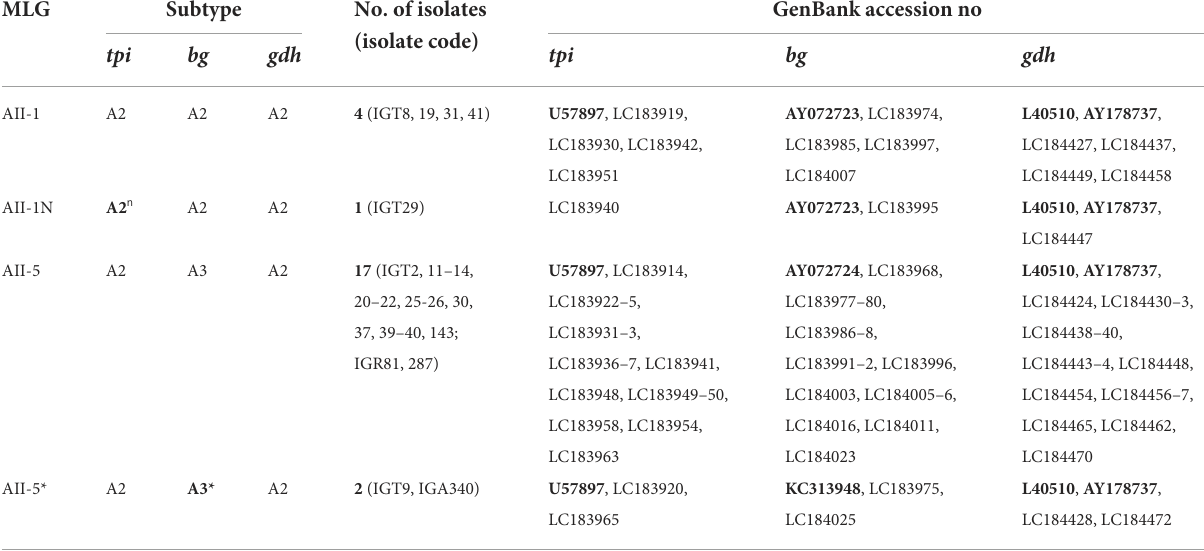
TABLE 7 Multilocus genotyping (MLG) and subtypes in Giardia duodenalis assemblage A–positive of Iranian isolates according to sequencing data from tpi (triosephosphate isomerase), bg ( β -giardin), and gdh (glutamate dehydrogenase) loci. MLG